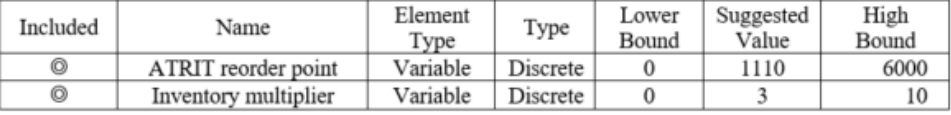
Figure 11. Setting values of decision variables for drug ABIL5.